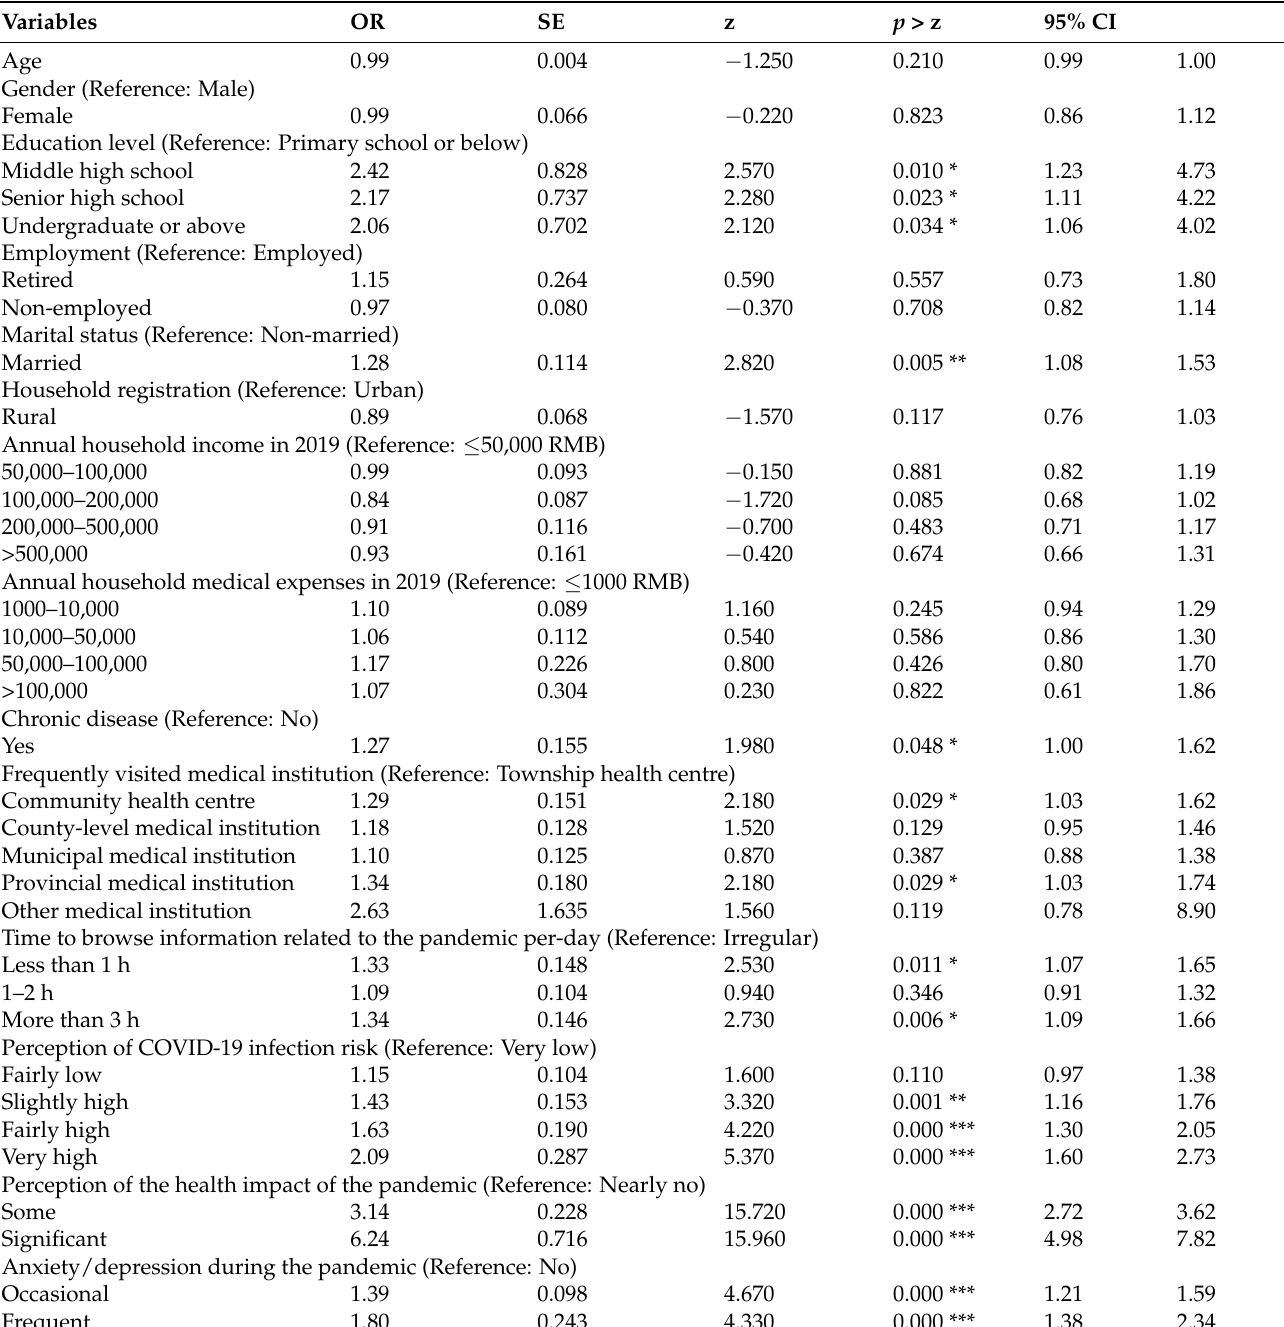
Table 2. Results of Logistic regression analysis on factors associated with reporting affected health services